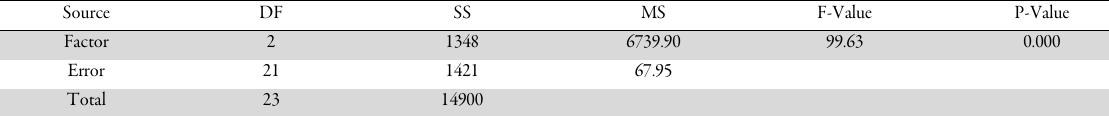
Table 1. Analysis of variance (ANOVA) of air layered D. tripetala seedlings